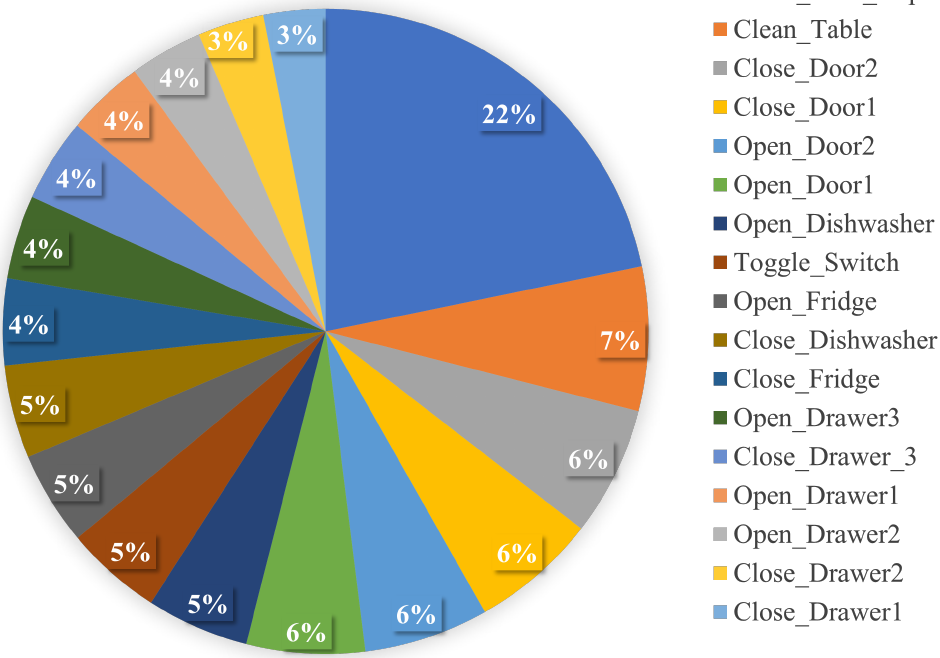
Figure 2. Activity distribution of the Opportunity